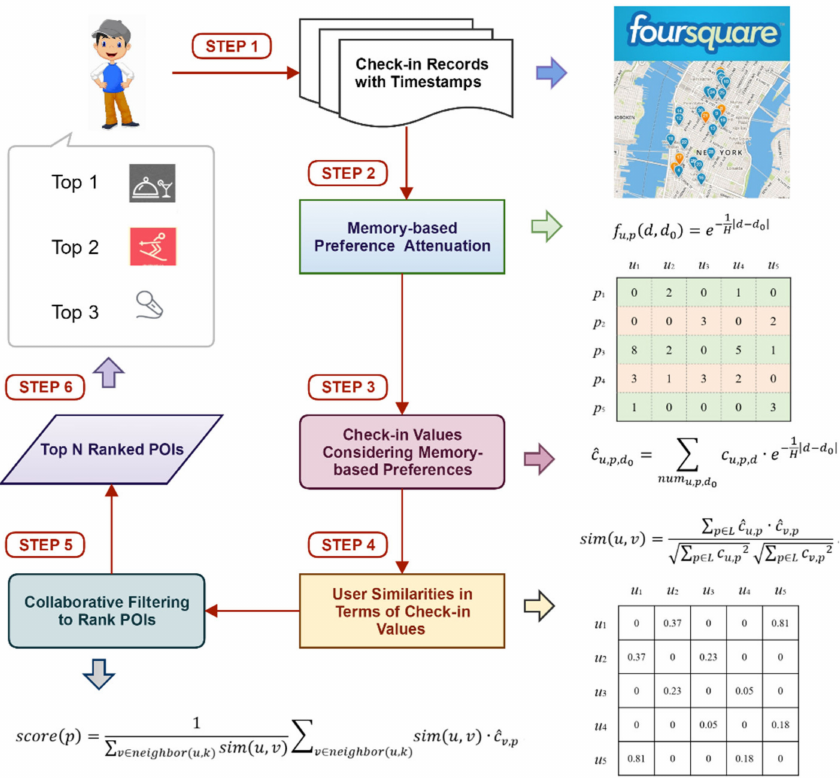
Figure 2. Flowchart of POI recommendation considering memory-based preference